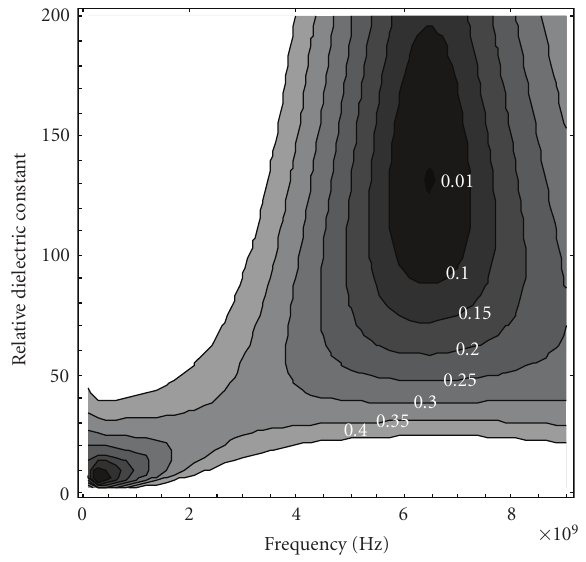
Figure 5: Contours of constant reflection magnitude at levels 30% above the best level determined for pure dielectric with no loss, for frequencies: 0.667, 1.33, 2.0, 3.0, 4.0, 5.0, and 6.0 GHz, as indicated on each curve on the figure. The 30% increased reflection contours have values: 0.17, 0.34, 0.42, 0.435, 0.37, 0.246, and 0.08, respec- tively. The optimal match dielectric constant for each frequency is indicated by the vertical line from the contour peak to the horizon- tal axis.